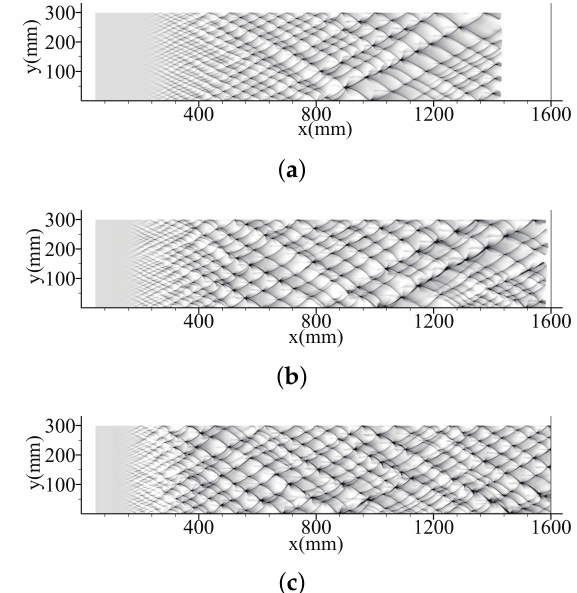
Figure 5. Numerical smoked foils without artificial perturbations, ( a ) k R = 2 s − 1 , ( b ) k R = 3 s − 1 , and ( c ) k R = 4 s − 1 .